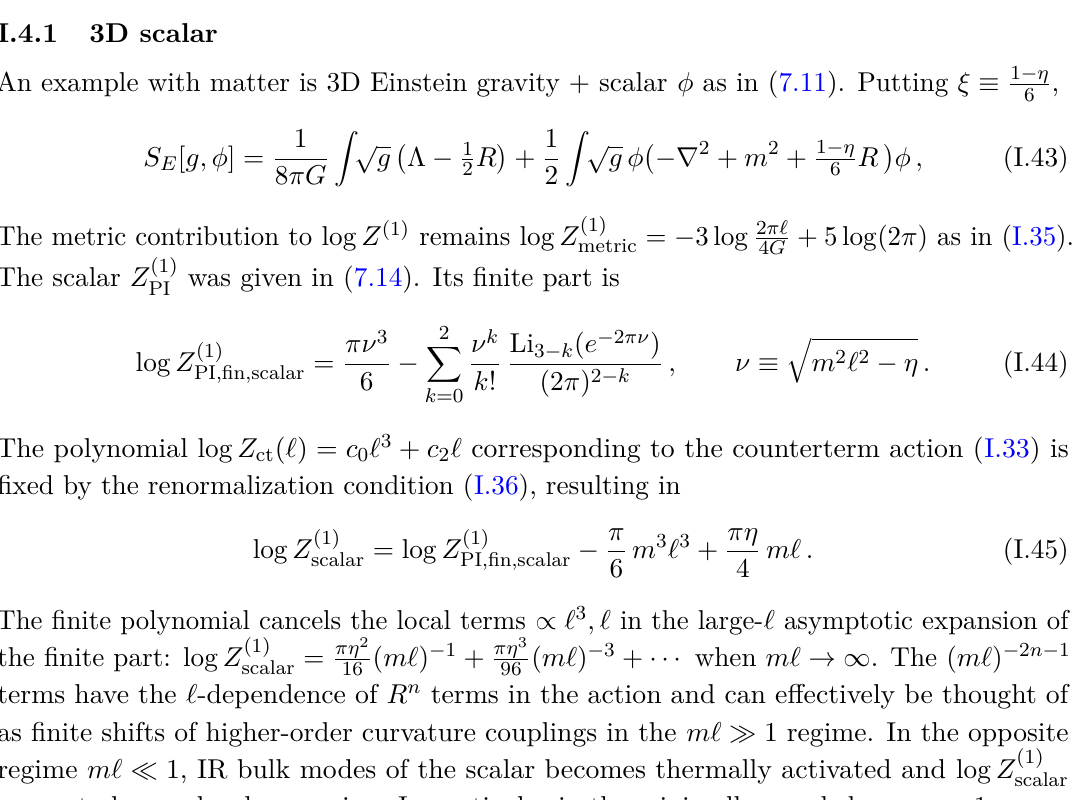
Figure 21 . One-loop contributions to the dS 3 entropy from metric and scalars with η = 1 , 1 . Blue dotted line = renormalized entropy S (1) . Green dotted line = horizon entropy ξ = 0 , 1 , − 1 8 24 change δS (0) = 2 πδ‘/ 4 G = − V ρ (1) due to quantum backreaction ‘ first law. Solid red line = total δ S = S (1) − V ρ (1) = log Z (1) . The metric contribution is negative within the semiclassical regime of validity ‘ (cid:29) G . The renormalized scalar entropy and energy density are positive for m‘ (cid:29) 1 , and for all m‘ if η = 1 . If η> 1 and ‘ ‘ ∗ δ‘ ∼ − G → −∞ , meaning the one-loop approximation breaks down. The scalar becomes 3 π ‘ 0 − ‘ ∗ tachyonic beyond this point. If a φ 4 term is included in the action, two new dominant saddles emerge with φ 6 = 0